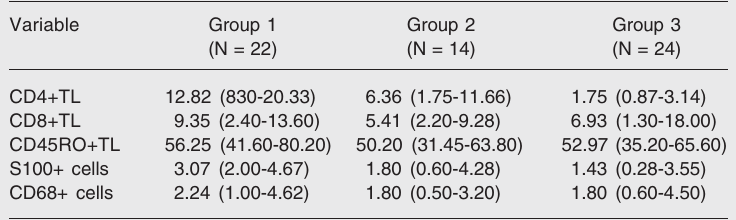
Data are reported as median number of cells/cm 2 in a high power field (lower-upper quartile). For group definitions, see legend to Table